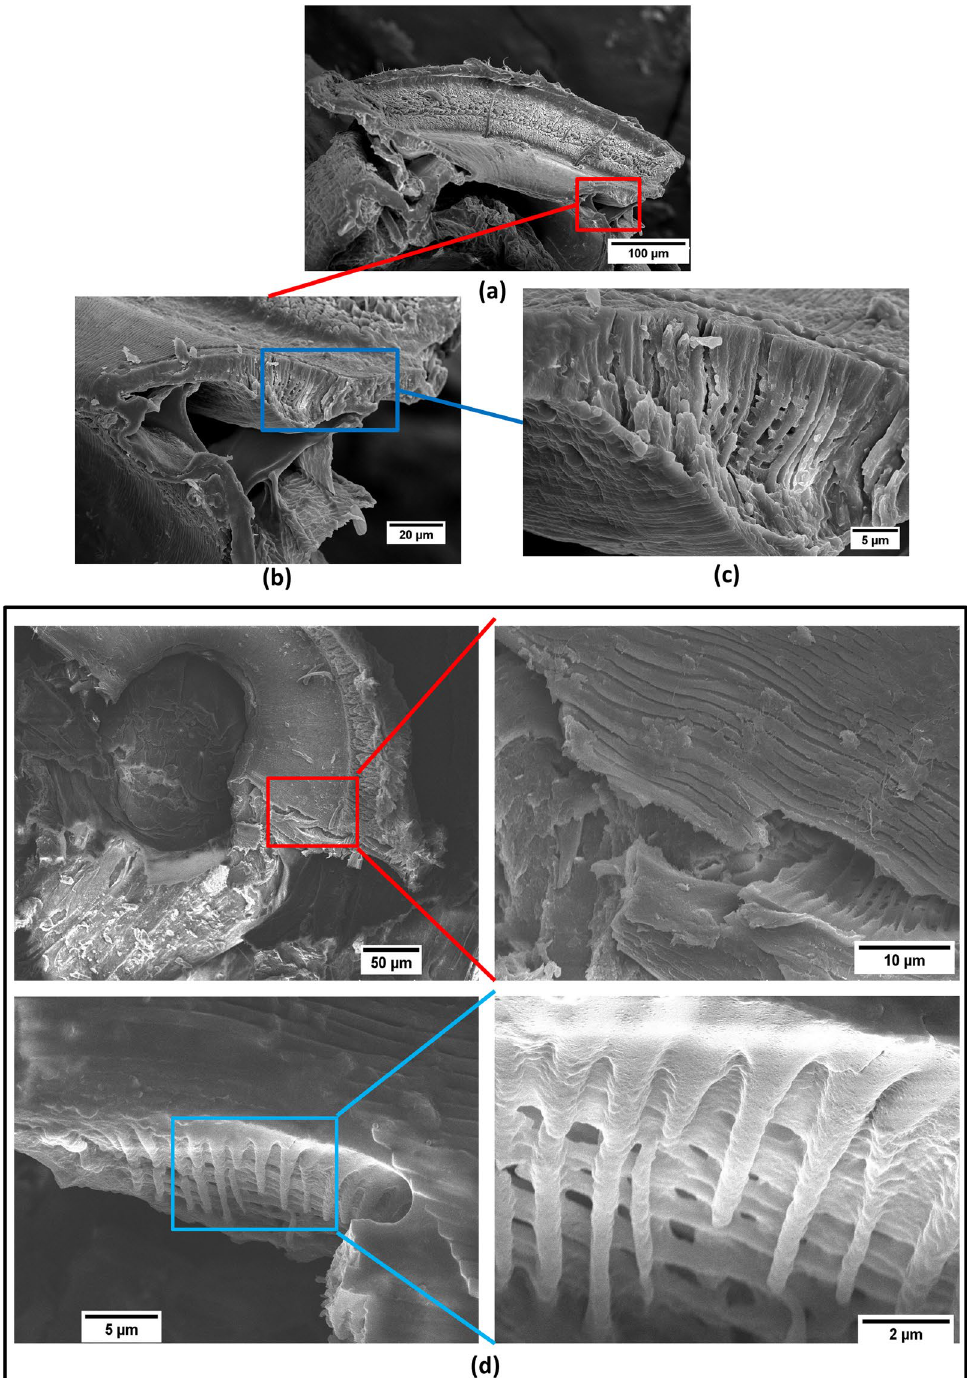
Figure 4. ( a ) The inner architecture of the sucker is similar to donut shape, which is hollowed inside. This architecture might be the tunnel for fluid to flow through, or provide flexibility for the sucker and helps it to adapt to a variety of surface profiles. ( b , c ) The alignment of fibers is perpendicular to the top wrinkled surface. ( d ) SEM micrographs at higher magnifications showing interwoven structure of the fibers can be observed. This interwoven structure might provide the strength of the